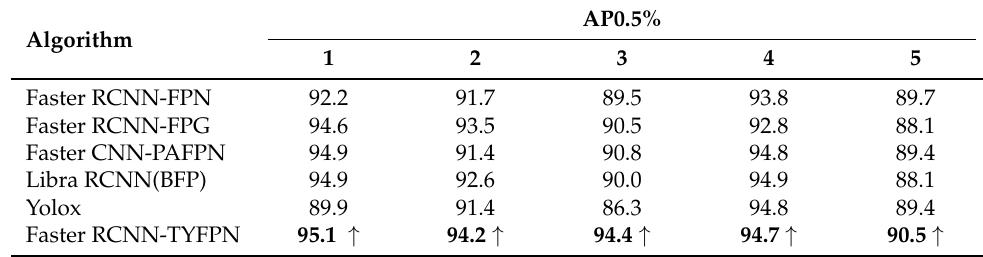
Table 3. AP0.5 evaluation metrics for different